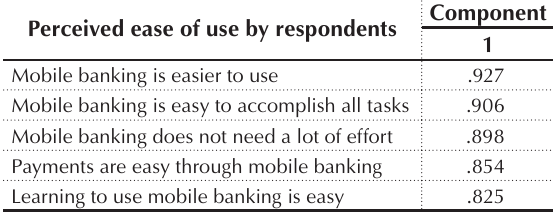
Table (cid:1006). (cid:38)(cid:258)(cid:272)(cid:410)(cid:381)(cid:396)(cid:3)(cid:258)(cid:374)(cid:258)(cid:367)(cid:455)(cid:400)(cid:349)(cid:400)(cid:3)(cid:381)(cid:374)(cid:3)(cid:393)(cid:286)(cid:396)(cid:272)(cid:286)(cid:349)(cid:448)(cid:286)(cid:282)(cid:3)(cid:286)(cid:258)(cid:400)(cid:286)(cid:3)(cid:3)